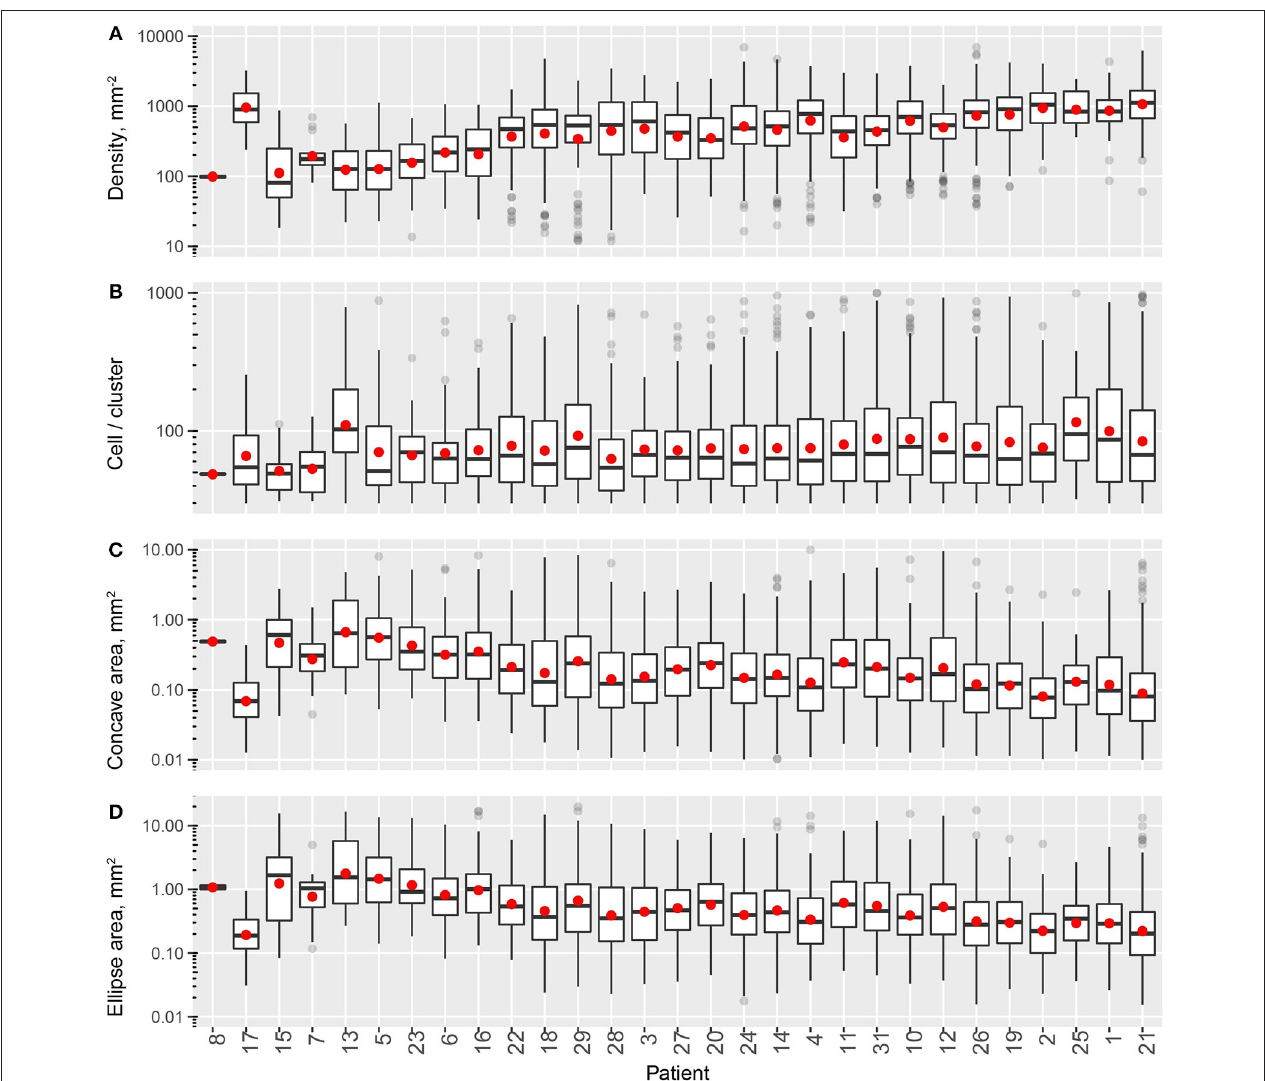
FIGURE 6 | Intra- and inter-tumoral heterogeneity quantification using cell cluster statistics. Patients are sorted by overall CD8 and lower hinges indicate 25th and 75th percentiles, respectively. Red dots indicate the mean value. (A) Within-cluster density of CD8 per cluster. (C) Cluster area, measured as areas of alpha-shape. (D) Cluster area, measured as the area of 95% level fitted